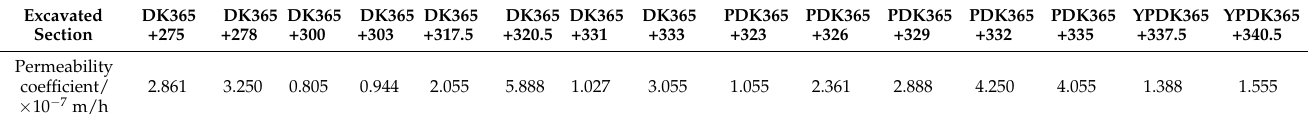
Table 21. Permeability coefficient after grouting in different